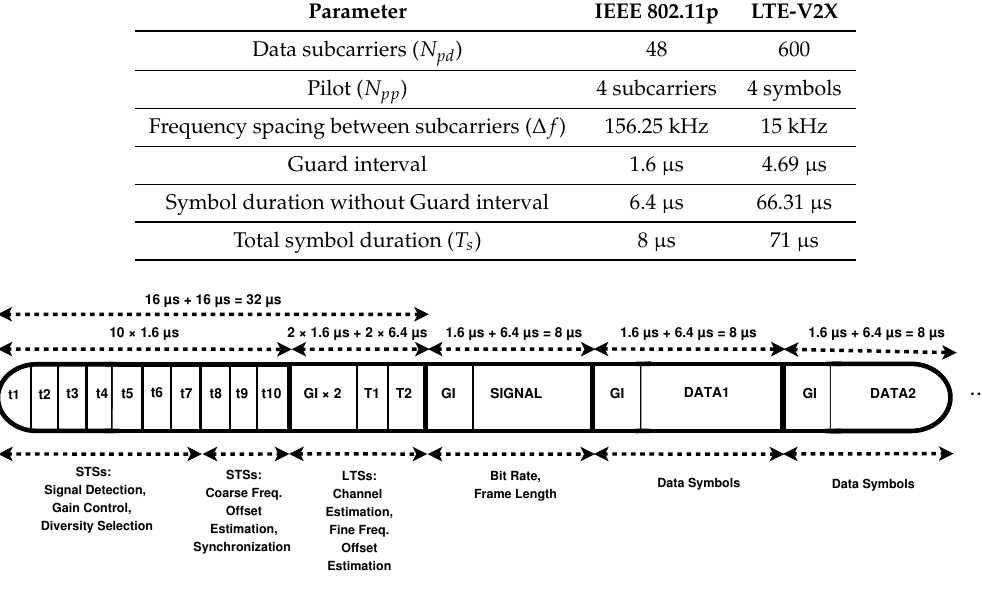
Figure 1. IEEE 802.11p frame structure with a 10 MHz bandwidth